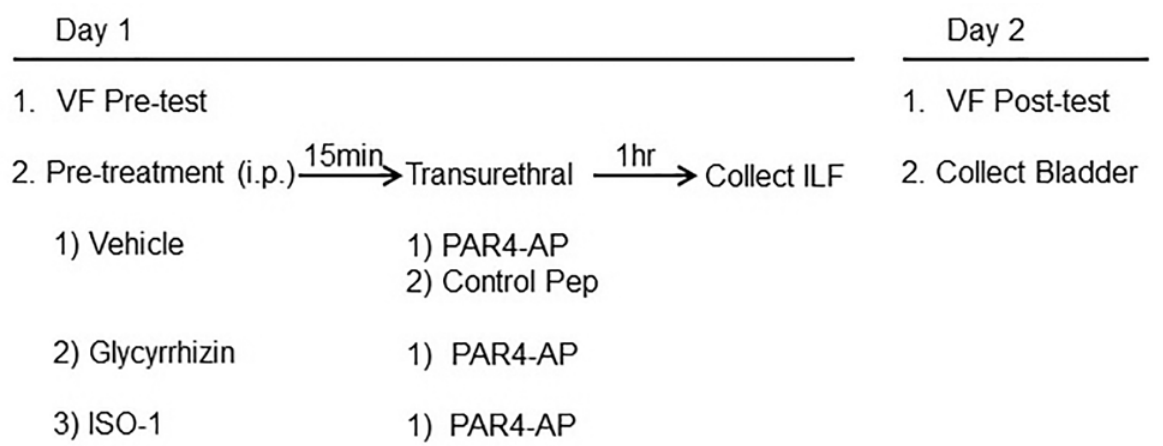
Fig 1. The flow chart demonstrates in vivo study in mice with